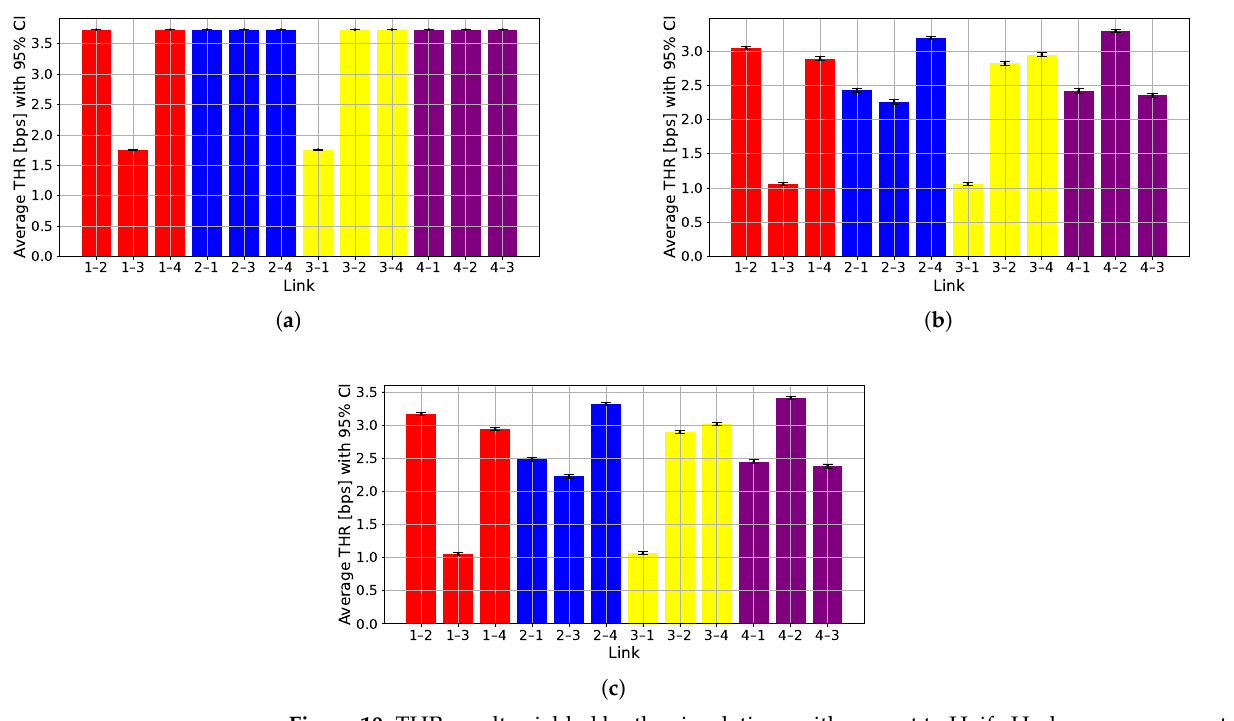
Figure 10. THR results yielded by the simulations with respect to Haifa Harbor measurements for UWPhysical ( a ), UWHMMPhysical ( b ), and UWHMMPhysicalExt ( c